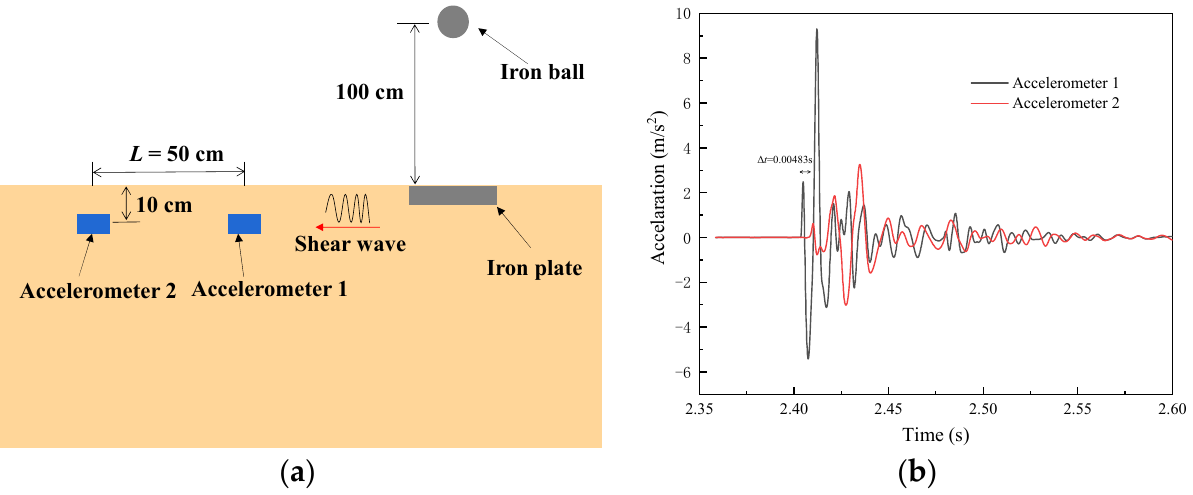
Figure 3. Shear wave velocity method: ( a ) sketch of test, ( b ) measured acceleration signals.